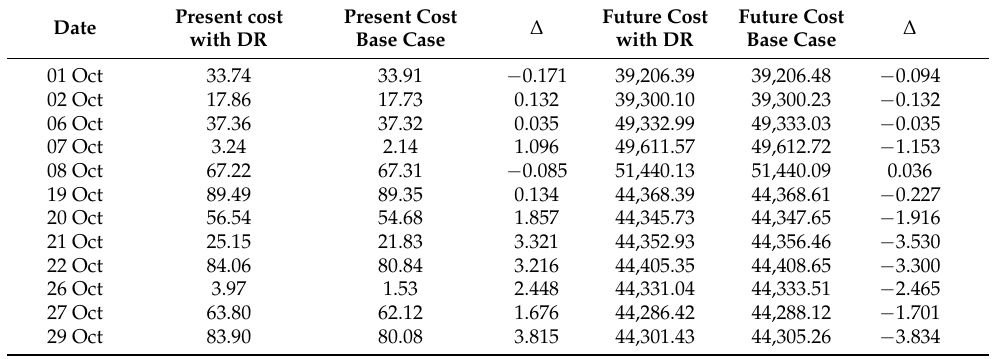
Table 6. Differences between present and future costs considering the DR activation and base